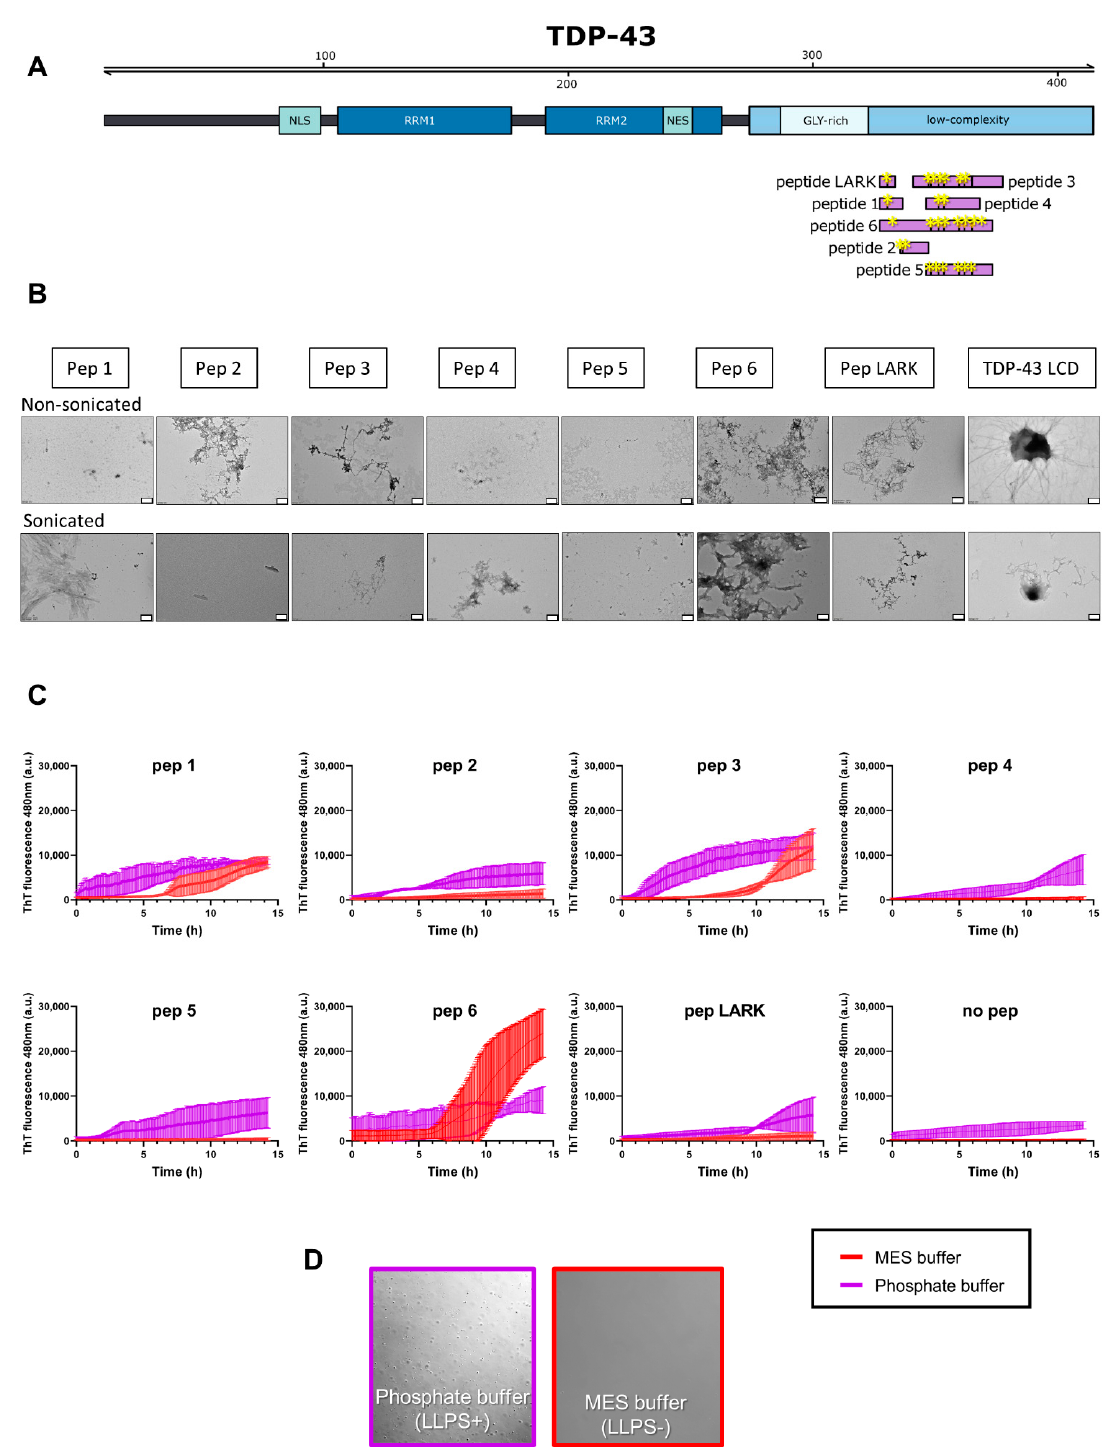
Figure 4. Effect of sonicated TDP-43 peptides on TDP-43 LCD aggregation. ( A ) Overview of the peptide regions within the LCD of TDP-43; yellow “*” indicates the location of potential disease-causing mutations within these peptide regions. ( B ) Visualization of the TDP-43 peptides 1–6, the LARKS peptide and TDP-43 LCD using EM at a magnification of 20,000 × . Scale bar is 500 nm. Peptides were dissolved in water, filtered and left to age for 2 days. Subsequently, peptides were sonicated or not, as indicated. ( C ) ThT curves of representative sonicated peptides and TDP-43 LCD in the presence (purple) and absence of LLPS buffer (red) with TDP-43 LCD (10 µ M). Mean ± SD of n = 3 independent experiments. ( D ) Differential interference contrast (DIC) image of 20 µ M TDP-43 in LLPS+ and LLPS-